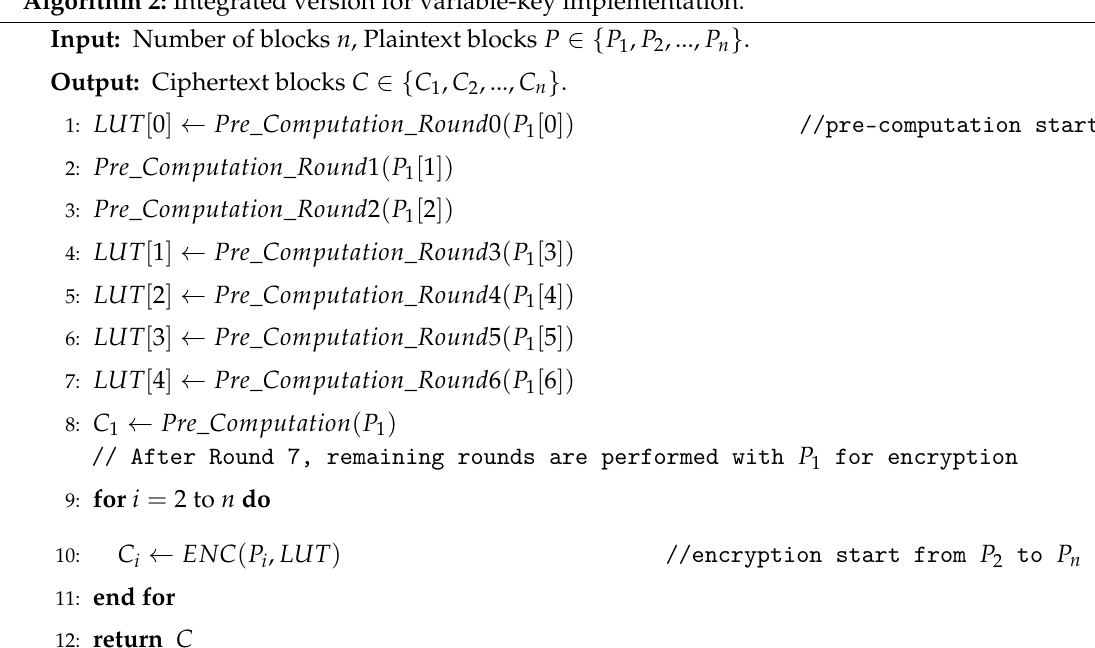
Algorithm 2: Integrated version for variable-key